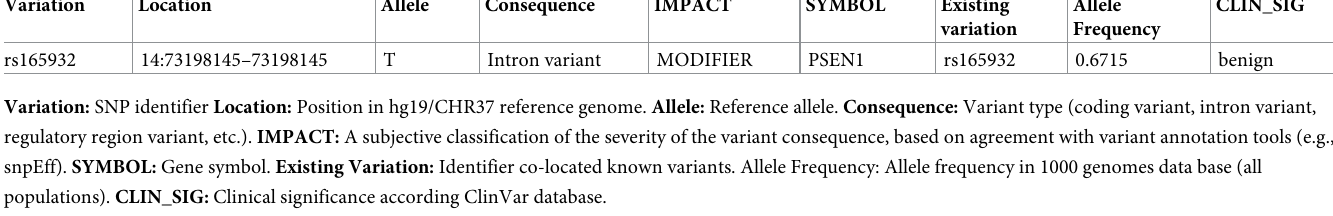
Table 1. Analysis of rs165932 polymorphism using VEP (Variant Effect Predictor) tool version 1.18. Variation Location Allele Consequence IMPACT SYMBOL Existing rs165932 14:73198145–73198145 T Intron variant MODIFIER PSEN1